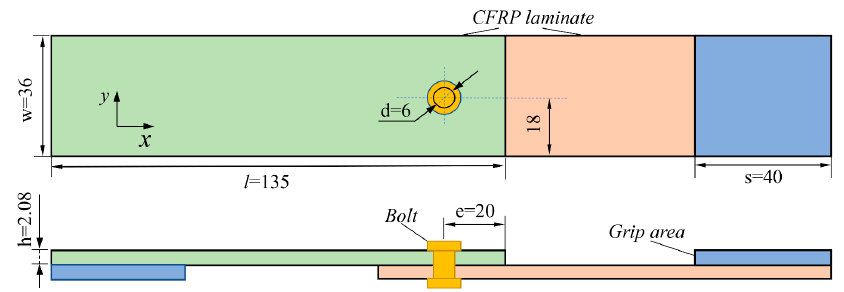
Figure 1. Single ‐ lap joint configuration of T700/2510 CFRP (Unit: mm).